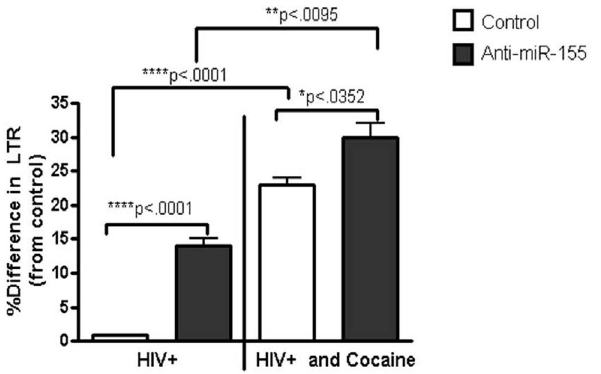
Figure 3. miR-155 inhibition enhances HIV-1 replication. MDDCs (1 6 10 6 cells/ml) from normal donors were transfected with anti-miR- 155, at a final concentration of 75 nM, followed by infection with HIV-1 (20 ng) and treatment 6 cocaine (1 m M). Total RNA was extracted and amplified by RT-PCR for HIV-1 LTR/RU-5 gene, to detect early steps in HIV reverse transcription. Significance is calculated with respect to non targeting HIV-1 control cells. Graphs are represented as % difference from control. Results shown are representative of mean 6 SEM of three experiments. p-value # 0.05 were considered to be significant.